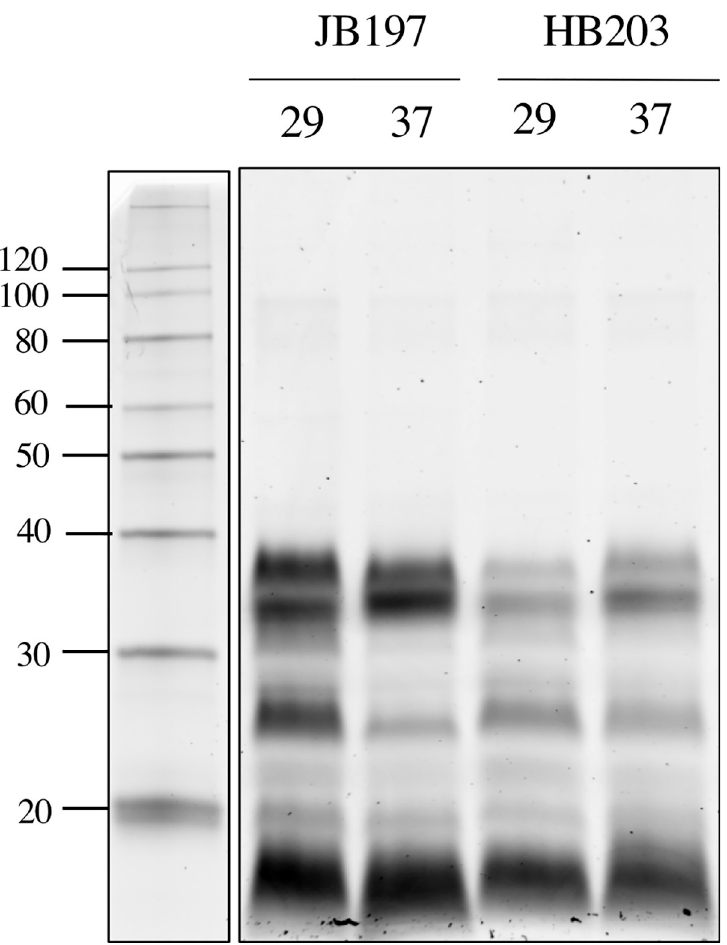
Fig 6. Evaluation of lipopolysaccharide expression in JB197 and HB203. Total lipopolysaccharide expressed by the equivalent of 5ug of serovar Hardjo strain JB197 and strain HB203 at 29 or 37˚C. Molecular mass markers (kDa) are